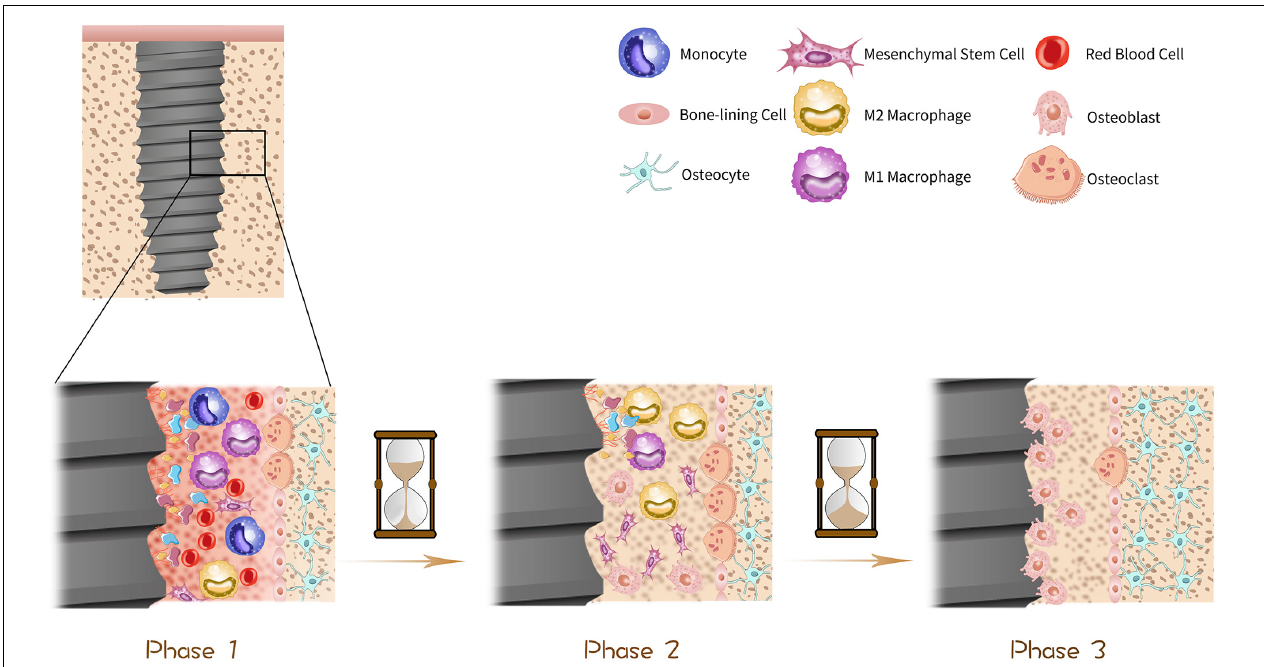
FIGURE 1 | Procedure of osseointegration. The histological change of dental implants in bone can be divided into three phases in general. In phase one, as soon as the implantation, the implant surface is surrounded by blood and immediately biomolecules including proteins, lipids and glycoproteins are absorbed to the surface, forming a temporary bioactive layer, with bone marrow cells scattering around. In phase two, about 1 month after the operation, some parts of bone tissue become absorbed due to the excessive pressure exerted on them, which is driven by osteoclasts. Simultaneously, the temporary bioactive layer is absorbed by macrophages and osteogenic cells such as mesenchymal stem cells (MSCs) and osteoblasts are stimulated to migrate to osteogenic area on the surface of implants and start to proliferate and differentiate thus mineralization procedure is initiated. In phase three, about 3 months after the implantation, the implant surface is surrounded by osteoblasts and osteocytes which get mature gradually, thus osseointegration is done progressively over